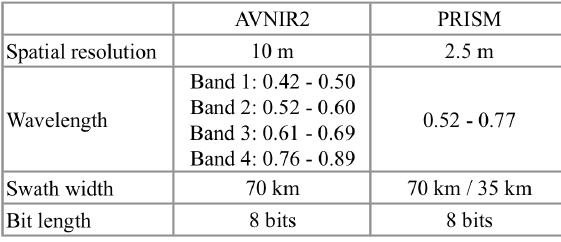
Table 1. Characteristics of AVNIR-2 and